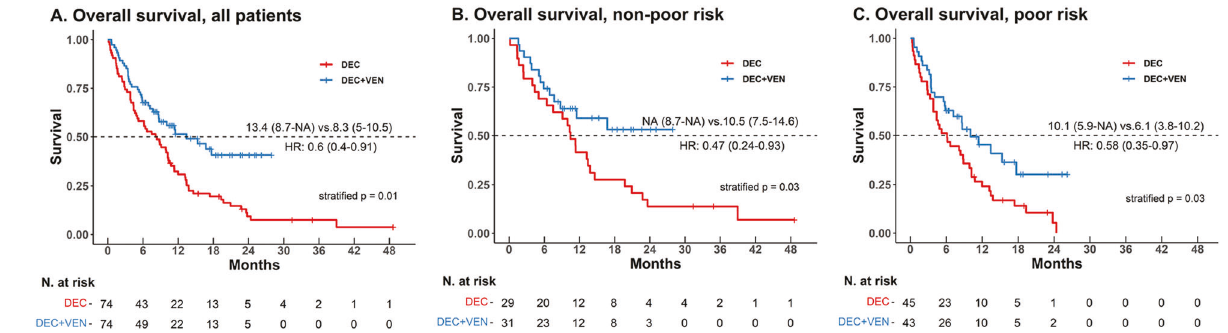
Fig. 1 Overall survival, strati fi ed by Wheatley risk groups. A Overall survival of all patients. B Overall survival of non-poor Wheatley risk patients. C Overall survival of poor Wheatley risk patients. DEC decitabine, HR hazard ratio, NA not available since the median was not reached, VEN